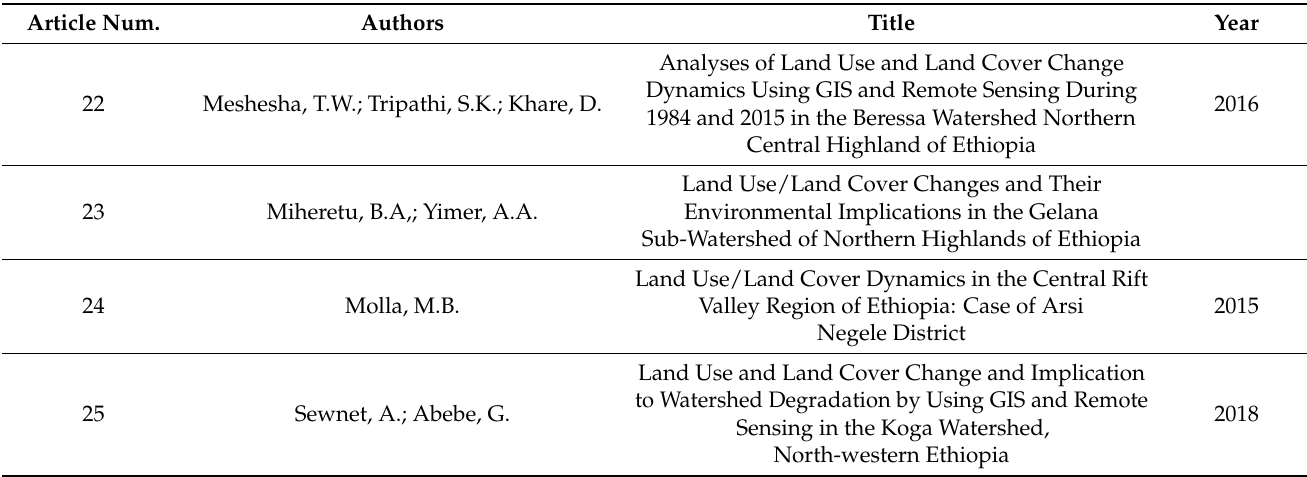
Figure 2. Main locations of the studies. Some reviewed articles referred to the same watershed, hence are here reported only once. The Ethiopian borders are indicated with a black line.